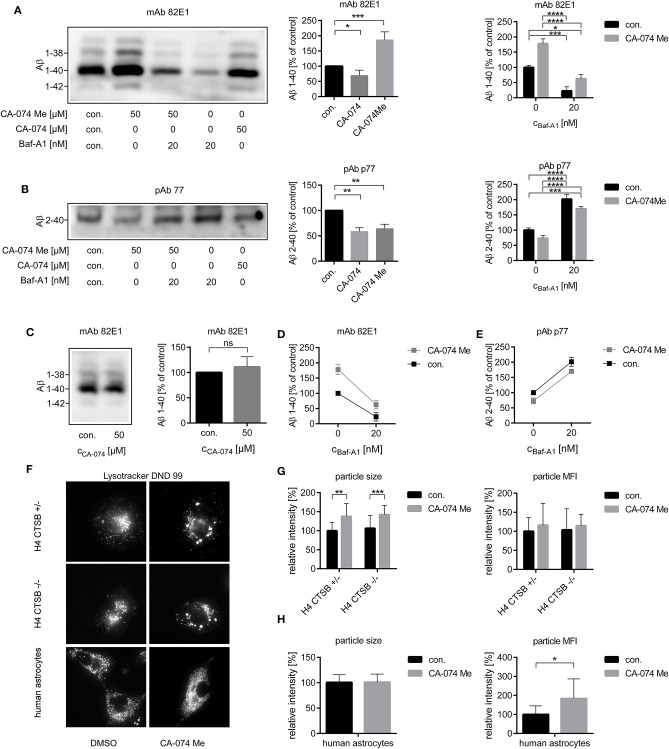
Four milliliters (A,C,D) or 20 ml (B,E) of conditioned media from H4 APP751 wt cells were used for the analysis of secreted Aβ. The relative amounts of Aβ 1-x (A) and of Aβ 2-40 (B) were decreased after the treatment of H4 APP741 wt cells with the cell-impermeant CatB-inhibitor CA-074 over 48 h. In supernatants of CA-074 Me treated cells, only the amount of Aβ 2-40 was decreased and the amount of Aβ 1-40 was conversely increased compared to controls. In cell free-conditioned media incubated over 48 h at 37°C, no decrease of the secreted Aβ 1-40 was observed, when CA-074 was added (C). Treatment with the H+-ATPase inhibitor Bafilomycin A1 (Baf-A1) decreased the amount of Aβ 1-40 (A) and increased Aβ 2-40 (B) compared to controls. Interaction plots with CA-074 Me and Baf-A1 as independent variables suggested, that the increase of dependent variable Aβ 1-40 after CA-074 Me treatment was dependent on the level of Baf-A1 (D), whereas no interaction was found for the dependent variable Aβ 2-40 (E). Stains with Lysotracker (F) showed an increased particle size in H4 cells (G) and an increased particle mean fluorescence intensity (MFI) in human astrocytes (H) after the treatment with CA-074 Me compared to vehicle treated cells (con.). This effect was also observed in H4 CTSB –/– cells, which indicated a CatB-independent effect of CA-074 Me on the morphology of lysosomes. Statistics: (A)
n = 5, ratio paired T-Test DMSO|CA-074 t(4) = 3.395, p < 0.05, ratio paired T-Test DMSOICA-074Me t(4) = 10.59, p < 0.001, (B)
n = 4, ratio paired T-Test DMSO|CA-074 t(3) = 8.544, p < 0.01, ratio paired T-Test DMSO|CA-074Me t(4) = 6.868 p < 0.01, (C)
n = 4, ratio paired T-Test t(3) = 1.056, p > 0.05 (D)
n = 3, Two-way ANOVA column F Baf-A1 (1, 8) = 68.54, p < 0.0001, row F CA-074 Me (1, 8) = 24.45, p < 0.0001, F interaction (1, 8) = 2.687, p < 0.05, (E) Two-way ANOVA F Baf-A1 (1, 8) = 89.70, p < 0.0001, F CA-074 Me (1, 8) = 7.734, p < 0.01, F interaction (1, 8) = 0.04241, p > 0.05, (G) Two-way ANOVA particle size F con. |CA-074 Me (1, 84) = 32.85, p < 0.0001, F CTSB +/−|CTSB –/– (1, 84) = 0.7853, p > 0.05, F interaction (1, 84) = 0.02116, p > 0.05, Two-way ANOVA particle MFI F con.|CA-074 Me (1, 80) = 5.279, p < 0.05, FCTSB +/−|CTSB –/– (1, 80) = 0.3039, p > 0.05, F interaction (1, 80) = 0.1415, p > 0.05, (H) unpaired T-Test particle size, t(16) = 0.05915, p > 0.05, unpaired T-Test particle MFI, t(15) = 2.351, p < 0.05. Tukey's post-hoc test was performed for multiple comparisons. Selected comparisons are indicated as follows ns p > 0.05, *p < 0.05; **p < 0.01; ***p < 0.001, and ****p < 0.0001). Each experiment was performed at least three times.